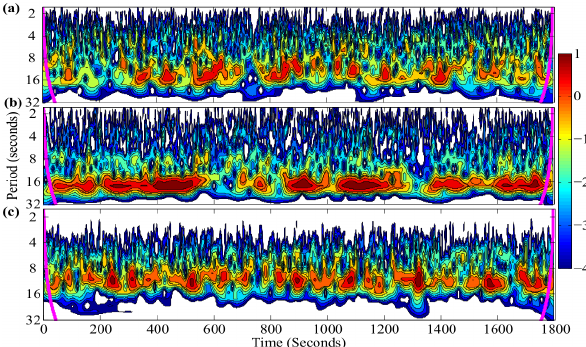
Figure 17. Wavelet power spectrum a) before cyclone (8 October 00:00 UTC), b) middle lifespan of cyclone (10 October 12:00 UTC) and c) cyclone close to the buoy location (12 October 10:00 UTC)